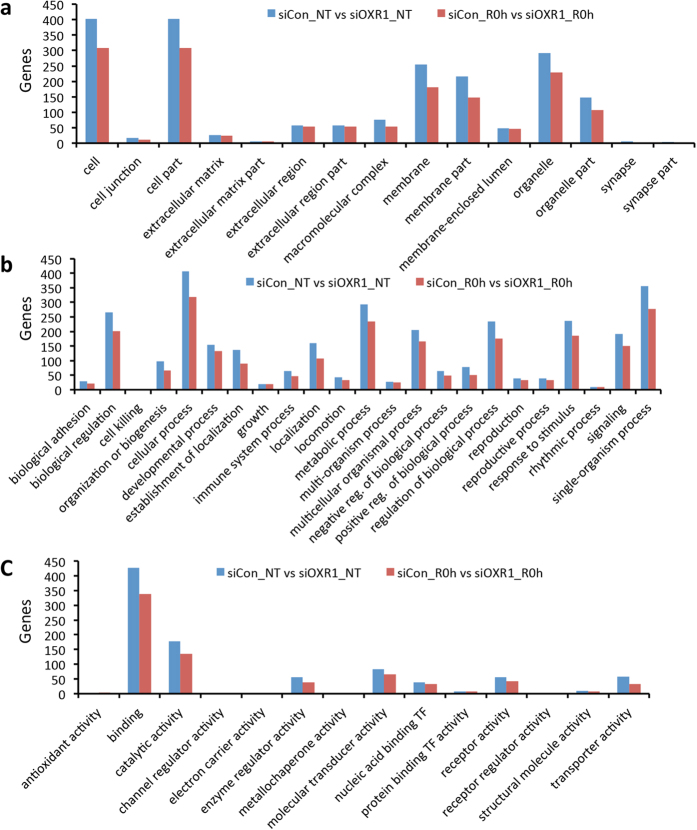
Gene ontology (GO) analysis of the deferentially expressed genes in hOXR1 depleted HeLa cells.The number of DEGs in each category was compared between non-treated (NT) and H2O2 treated (R0h) HeLa cells. (a) Cellular components. (b) Biochemical processes. (c) Molecular function.